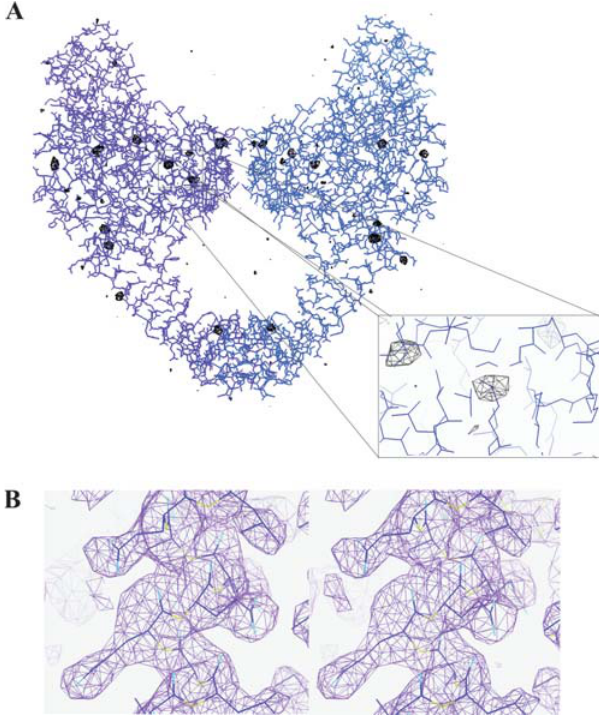
Figure 6. Electron density maps confirming the molecular replacement solution. (A) Superposition of the anomalous difference Fourier map calculated using Cys426 data collected on the chromium edge contoured at 3.5 s with the final refined model of ParC55. Panels were rendered using Coot [46]. (B) Stereo view of a region of the 2F obs -F calc electron density map from wild-type ParC55 data contoured at 1.5 s with the final refined model superimposed.